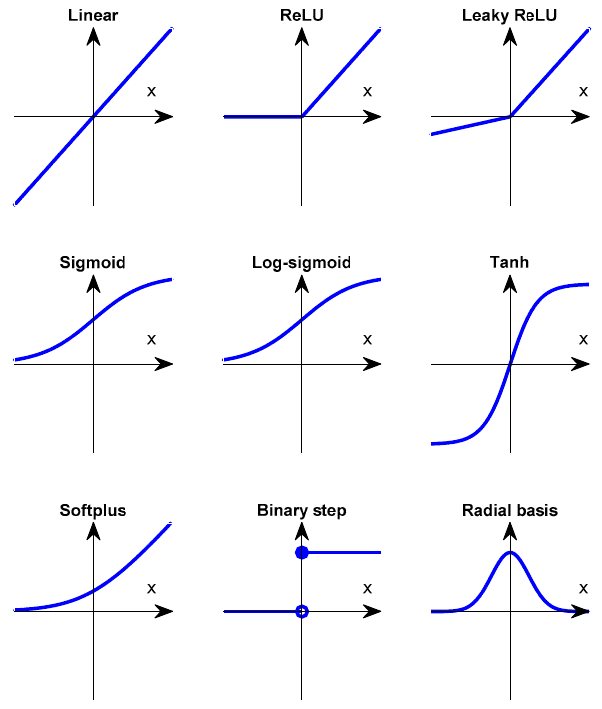
Figure 2. Common activation